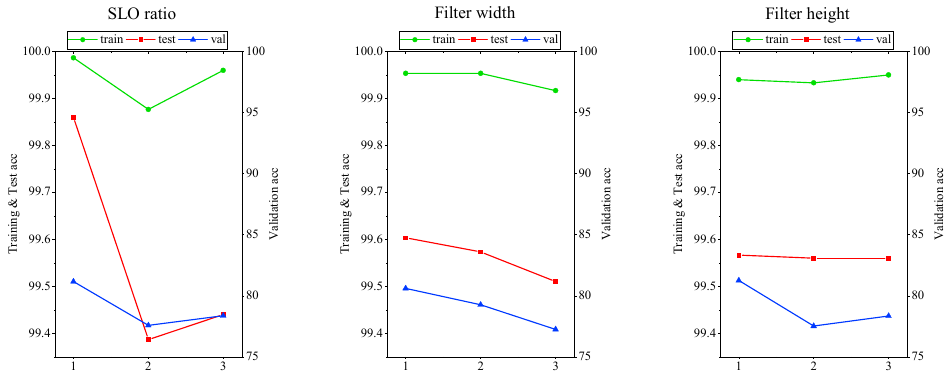
Figure 18. Results of the level average analysis of three major hyper parameters in terms of training, test, and validation accuracy.